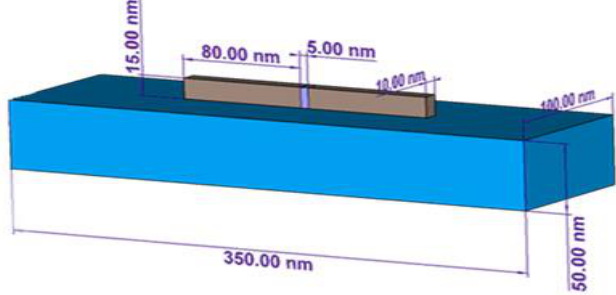
Figure 10. Schematic representation of the aluminum nano-dipole antenna, defining its geometrical parameters.